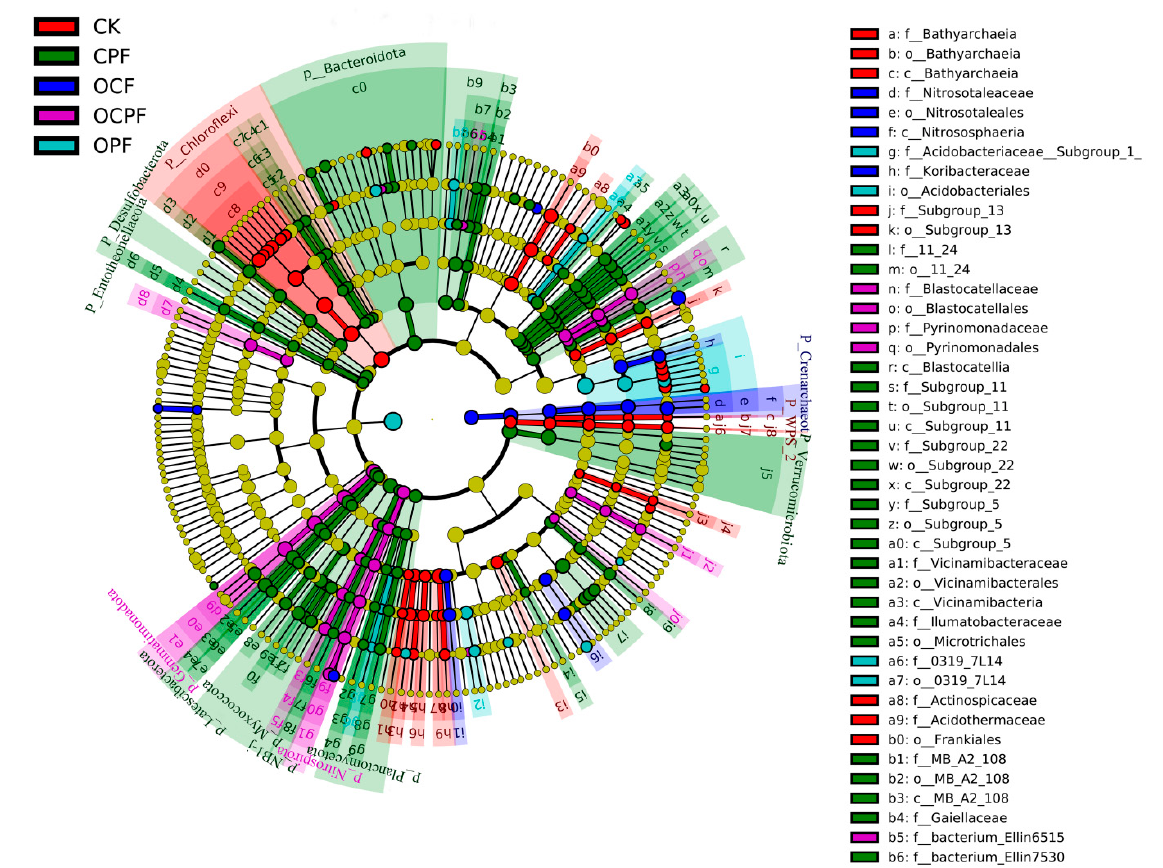
Figure 4. LEfSe analysis of soil bacterial biomarkers after different fertilization treatments. The circles radiating from the innermost to the outermost represent the taxonomic levels from phylum to species in the cladogram. The size of the circles is proportional to the size of the relative abundance. Species with no significant differences are colored uniformly yellow, and differential species biomarkers follow the group for coloring.